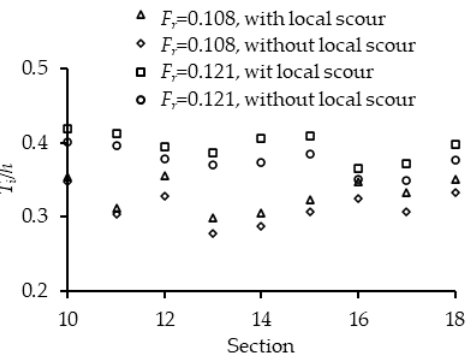
Figure 13. Relationship between Ti / h and F r with the presence of a local scour.